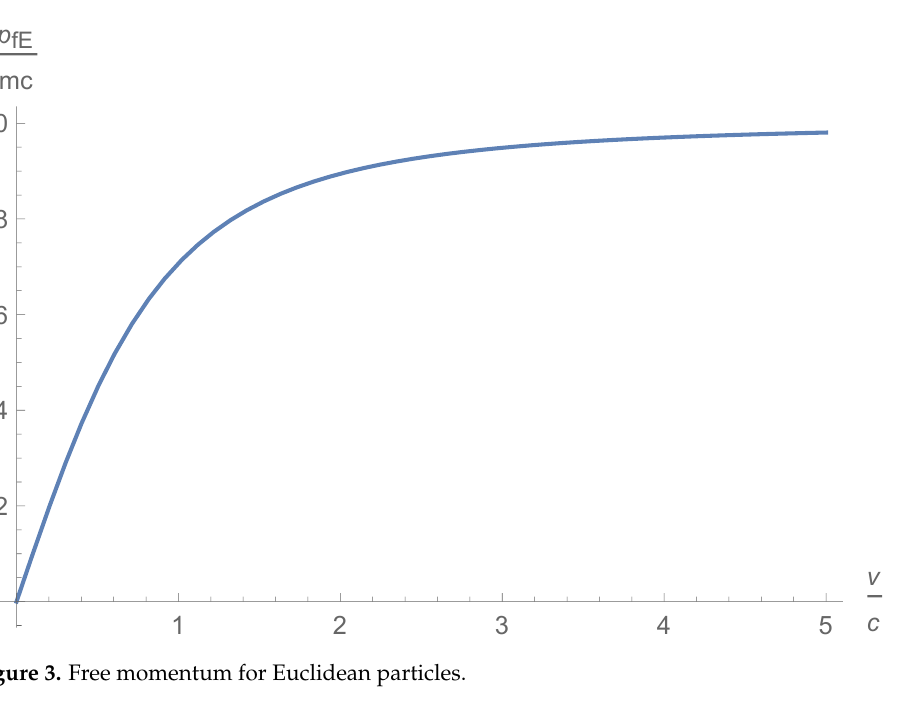
Figure 2. Free momentum for Euclidean subluminal particles, the correct expression is com- pared to the classical one. The blue line is the correct expression while the orange line is the classical approximation.